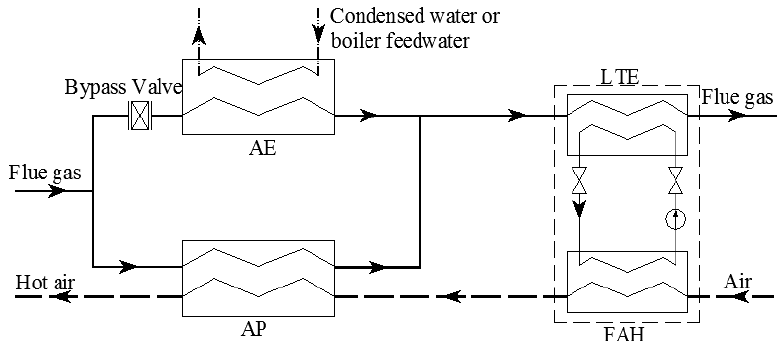
Figure 1. Coupled high-low energy grade flus gas waste heat recovery system. AE: Additional Economizer; AP: Air Preheater; LTE: Low Temperature Economizer; FAH: Front located Air Heater.